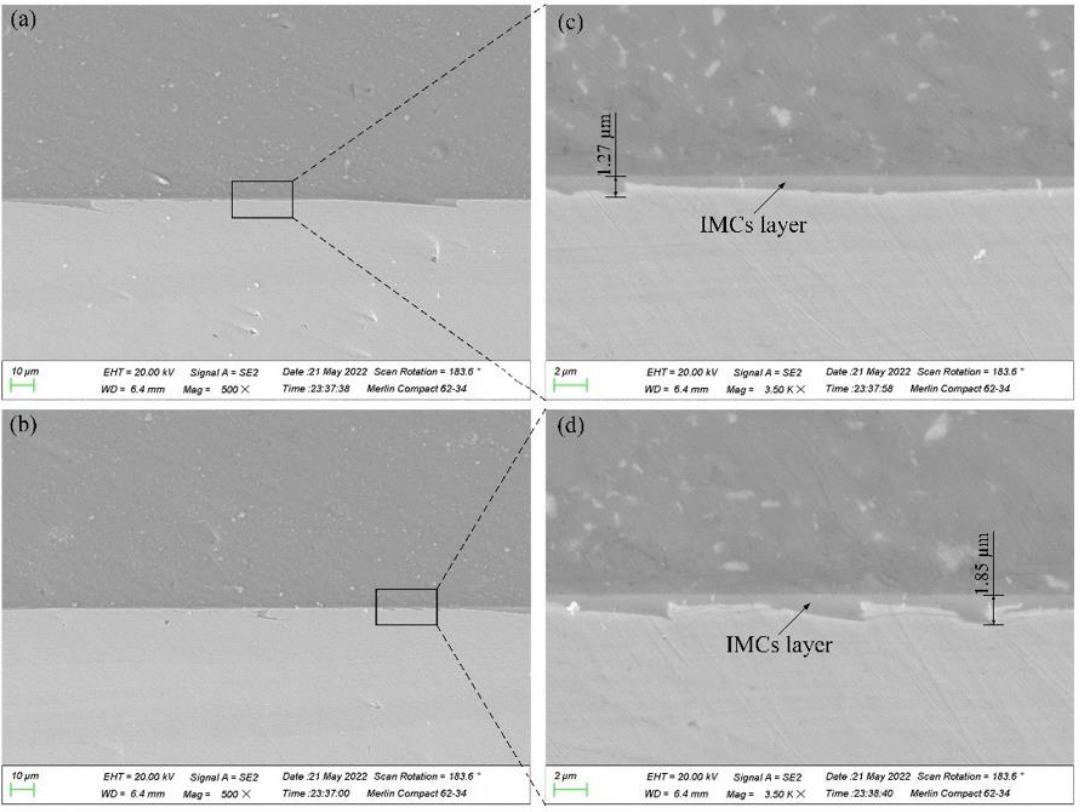
Figure 5. SEM analysis at region B: ( a , b ) 800 rpm; ( c , d ) 1200 rpm.